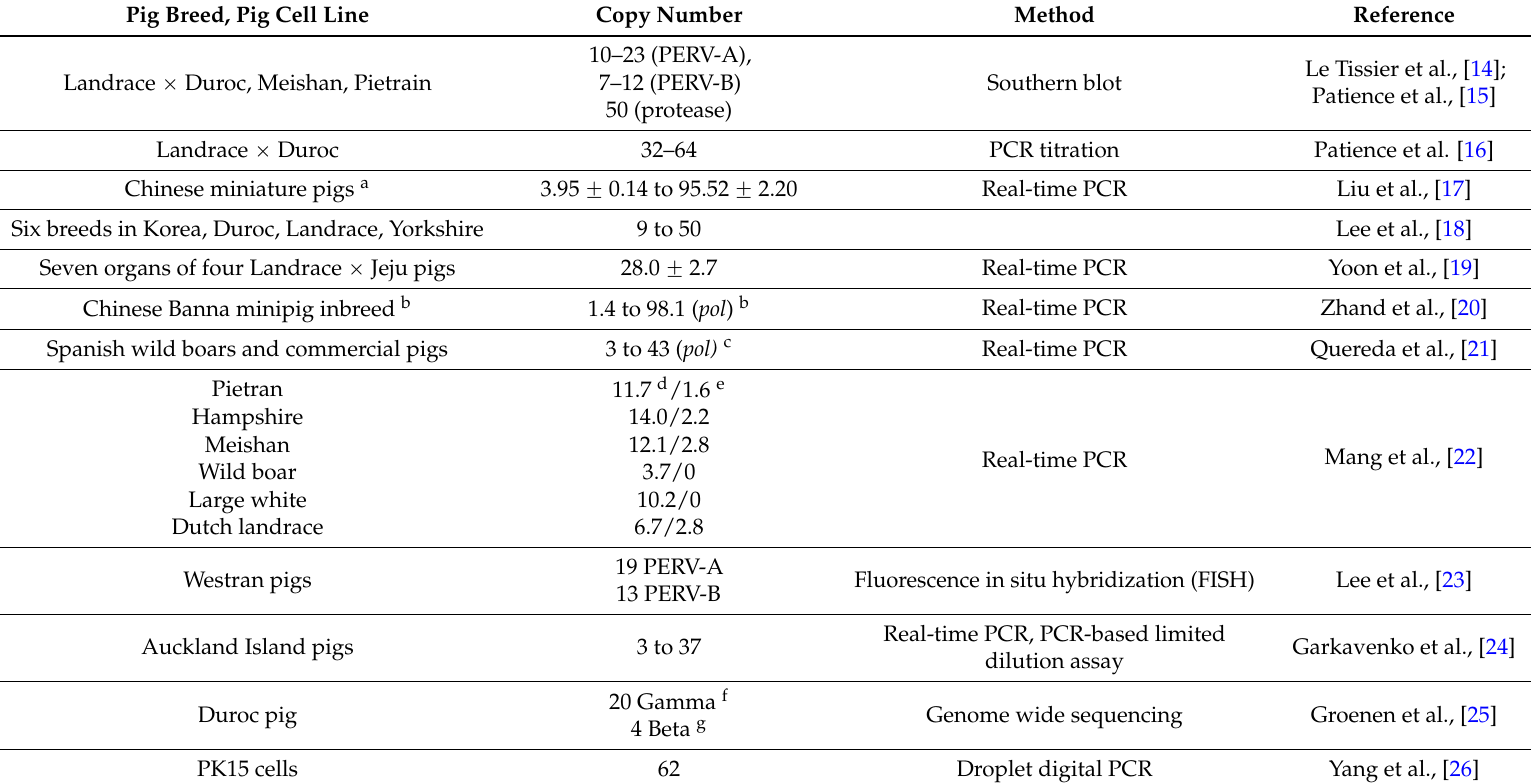
Table 1. Reported porcine endogenous retrovirus (PERV) copy numbers in different pig breeds and cell